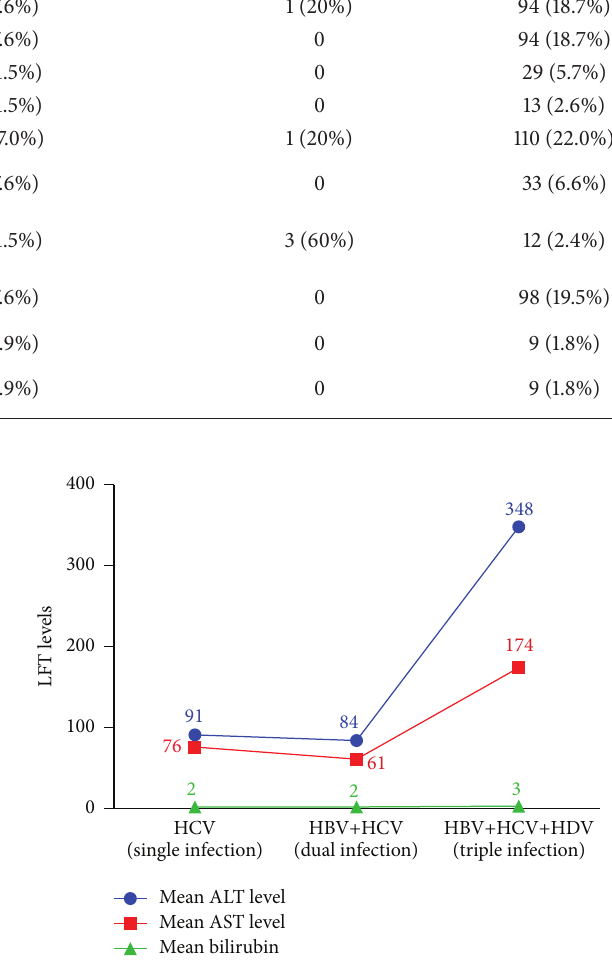
Figure 5: Comparison of liver function test results among HBV, HCV, and HDV positive